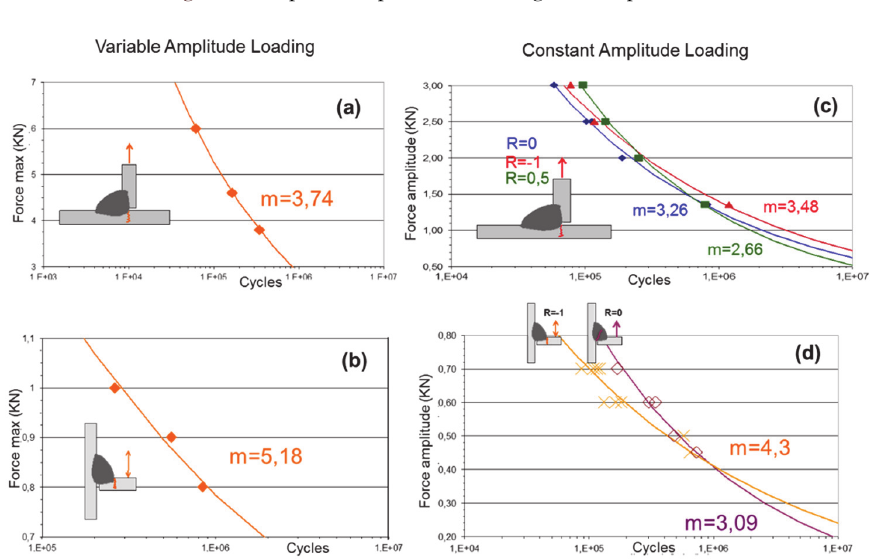
Figure 6: Comparison between constant and variable amplitude loading for tension and bending